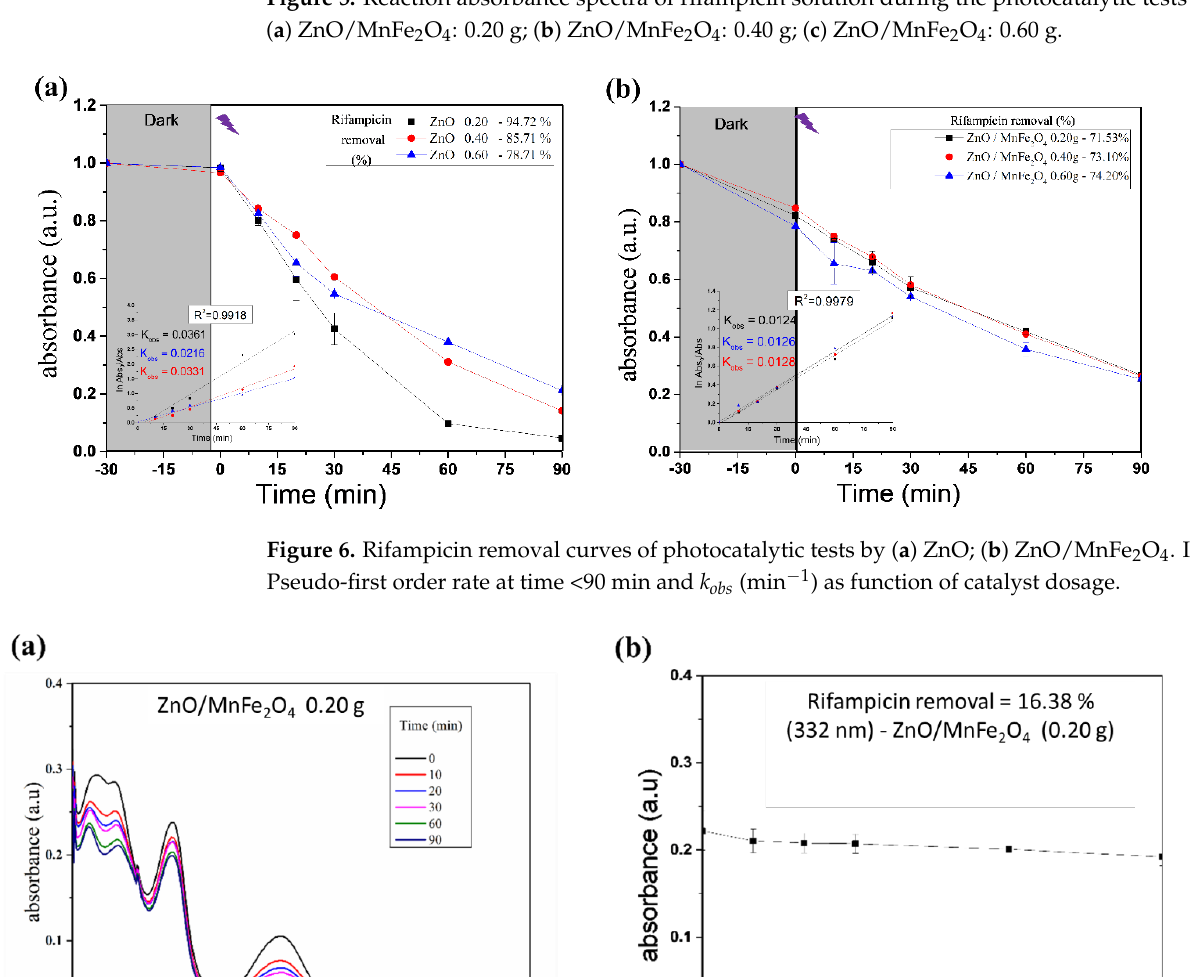
Figure 5. Reaction absorbance spectra of rifampicin solution during the photocatalytic tests using